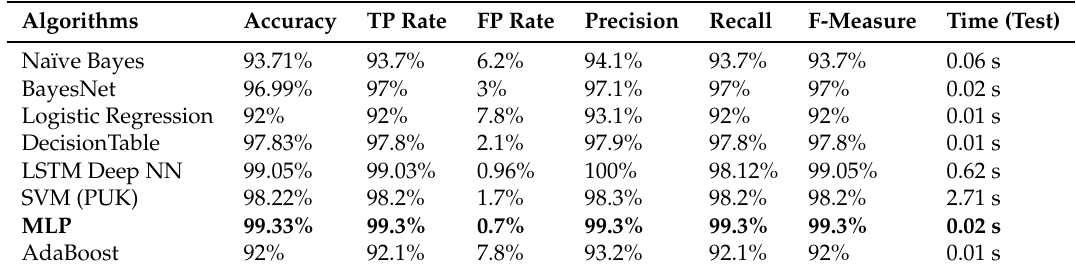
Table 12. Performance evaluation for attack scenario 9.